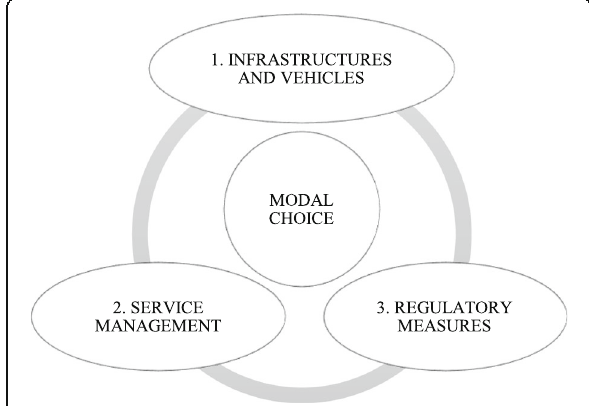
Fig. 3 Macro categories of measures that influence the users ’ modal choice